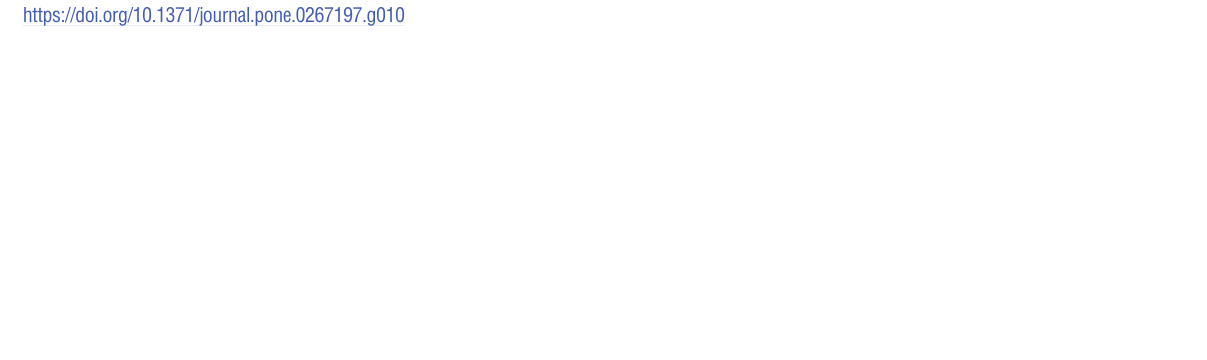
PLOS ONE | https://doi.org/10.1371/journal.pone.0267197 May 2, 2022 16 /